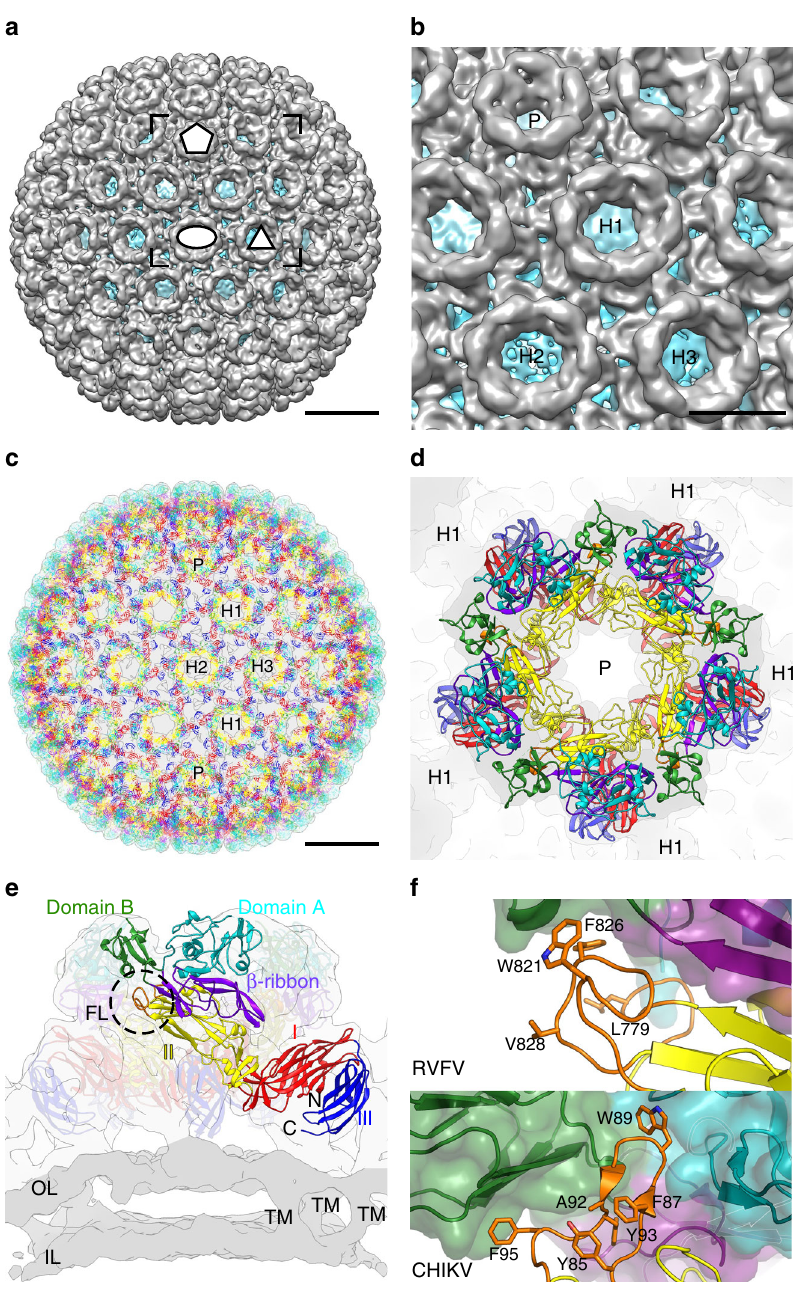
Fig. 2 Shielding of the Gc fusion loop in the Gn – Gc glycoprotein shell. a An icosahedral reconstruction of the virion at 13.3-Å resolution is shown. An icosahedral two-fold (ellipse), three-fold (triangle) and fi ve-fold (pentagon) axis of symmetry are marked. Scale bar, 20 nm. b A close-up of the area marked in a . A pentamer (P), type 1 hexamer (H1), type 2 hexamer (H2) and type 3 hexamer (H2) is labelled. Scale bar, 10 nm. c Virion model is shown along the icosahedral two-fold axis of symmetry. Atomic models of the pentamers and hexamers were fi tted to the 13-Å icosahedral reconstruction (transparent surface). One pentameric Gn – Gc capsomer (P) and three types of hexameric Gn – Gc capsomers (H1, H2 and H3) are labelled. d Pentameric capsomer is shown from the top. Localized reconstruction of the corresponding density at 7.7-Å resolution is shown as a transparent surface. Due to limited resolution of the localized reconstruction, secondary structure elements were constrained in MDFF fi tting to those observed in the crystal structures. We cannot, however, exclude the possibility that differences exist at secondary structure level between the native and crystallographic conformations. e Pentameric capsomer and the corresponding density is shown from the side. One Gn – Gc heterodimer is highlighted. Different domains and N-terminus and C-terminus are labelled. The fusion loop (FL) is circled. Outer (OL) and inner (IL) lea fl ets of the lipid bilayer are coloured in darker shade of grey and examples of transmembrane densities (TM) are labelled. Scale bar, 20 nm. f Close up of the Gn – Gc interaction (top) showing the shielding of the RVFV fusion peptide and reminiscent shielding of the fusion peptide in Chikungunya virus (CHIKV; bottom). Gn domains are coloured as in Fig. 1. Gc domain I is red, domain II yellow and domain III blue. Fusion loops are